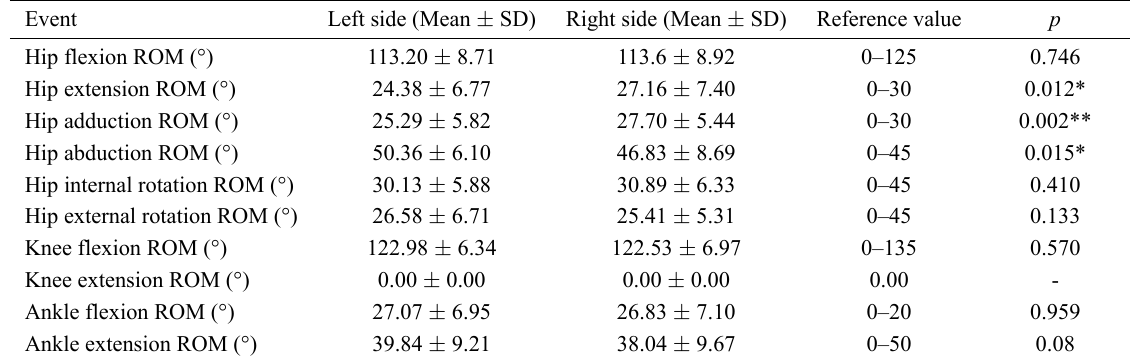
Table 3. The test results of lower limb joint range of young Middle distance runners (n = 48).